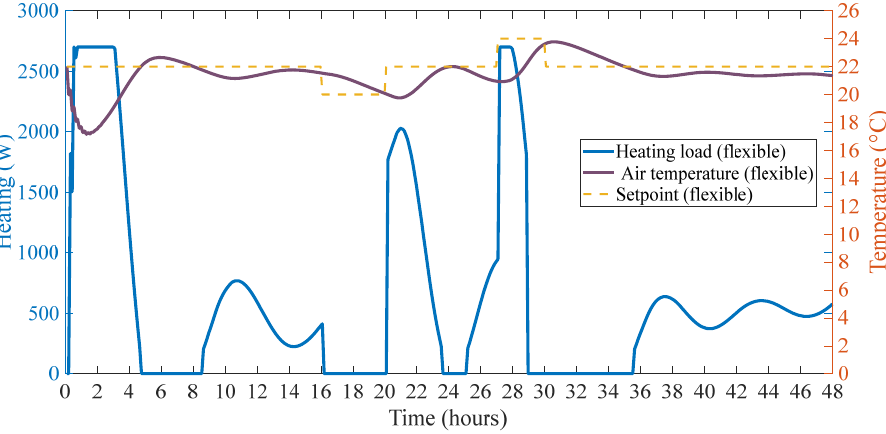
Figure 13. Upward flexible case for air temperature control.